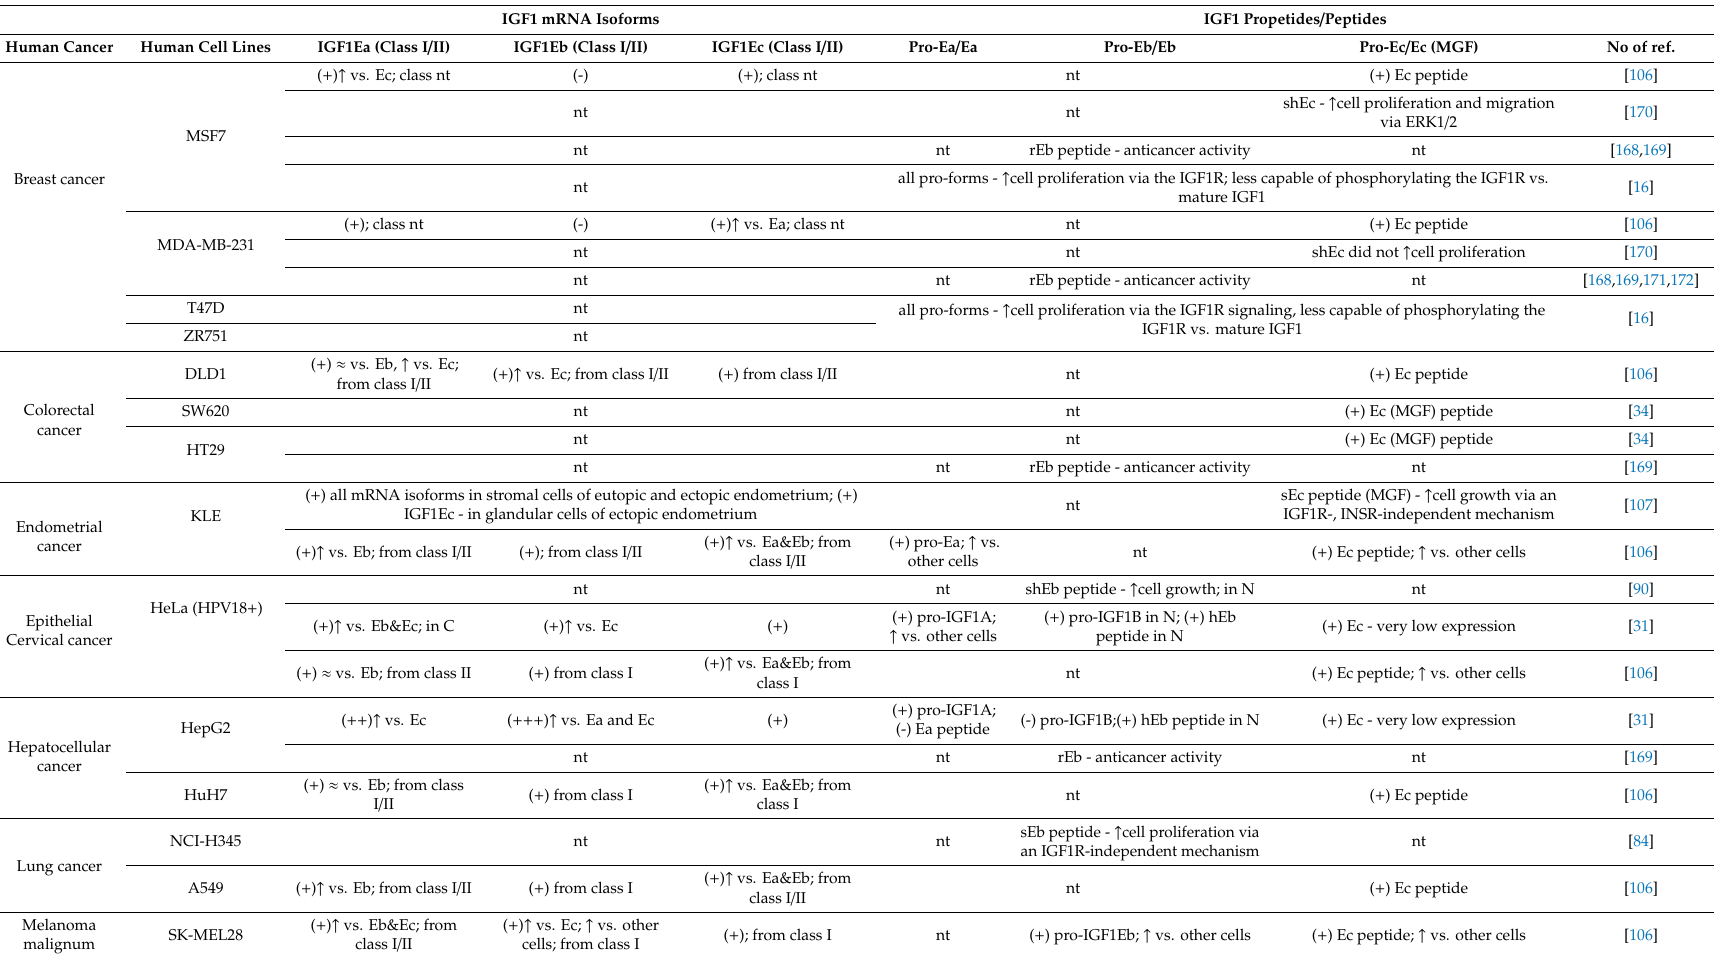
Table 2. Di ff erential IGF1 isoforms (mRNA, protein) expression in human cancer cell lines and mechanisms of action noted in in vitro